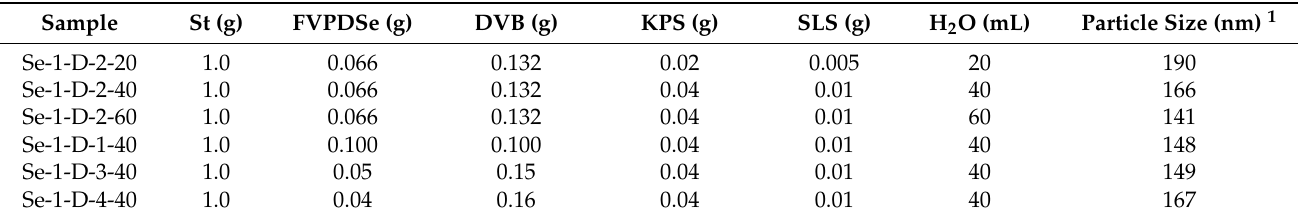
Table 1. A series of selenium-containing DSe-PS microspheres with different particle sizes or diselenide content.